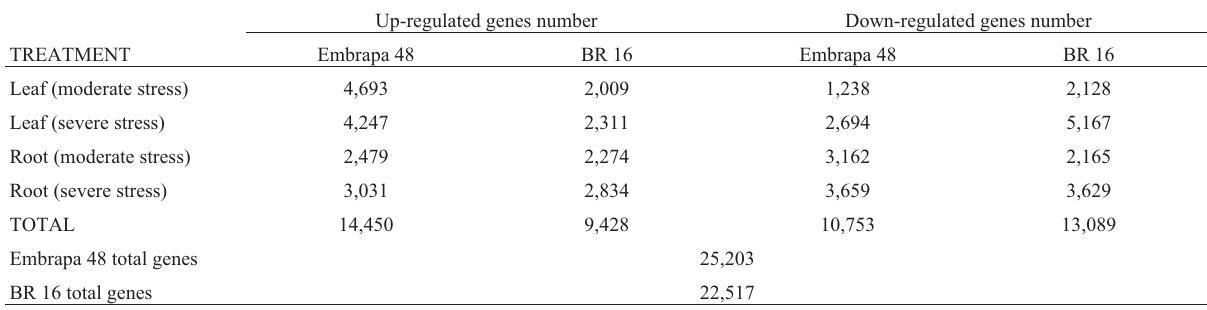
Table 2 - General information obtained in the RNA-seq analysis of the cultivars Embrapa 48 and BR 16 under water deficit